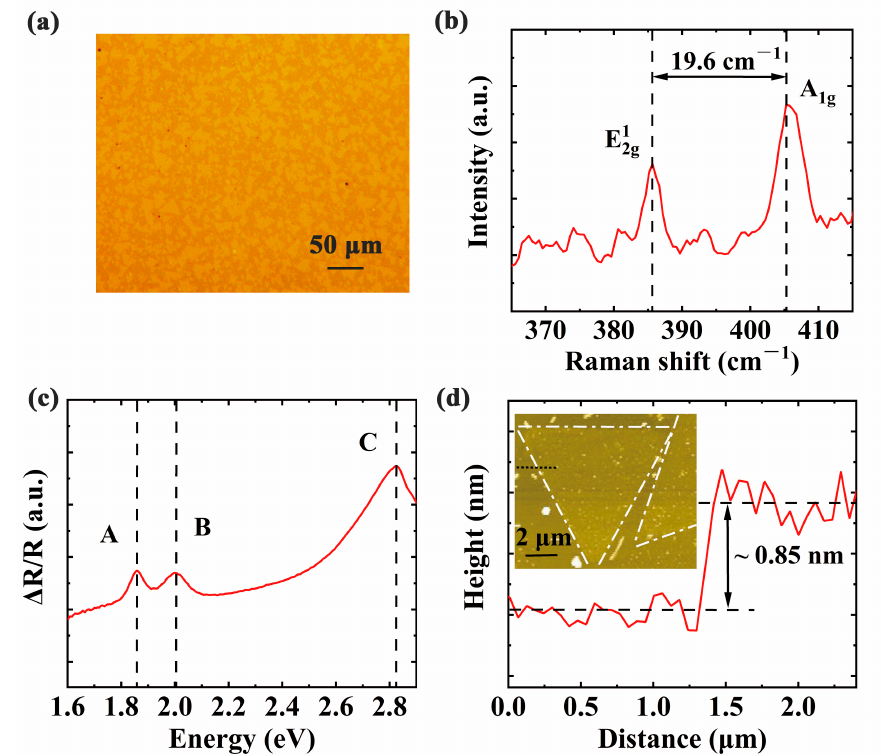
Figure 4. The ex-situ characterizations of the MoS 2 sample at room temperature. ( a ) An optical image of MoS 2 flakes on the sapphire substrate. The scale bar is 50 μ m; ( b , c ) Raman spectra and DRS of MoS 2 flakes respectively. A, B, and C represent three characteristic peaks of MoS 2 at different energy, respectively.; ( d ) An atomic force microscopy (AFM) height profile recorded the triangular MoS 2 flakes along the black short-dot line. Triangular MoS2 flakes are marked with white dash-dot lines. The inset is the corresponding graph with the scale bar of 2 μ m.